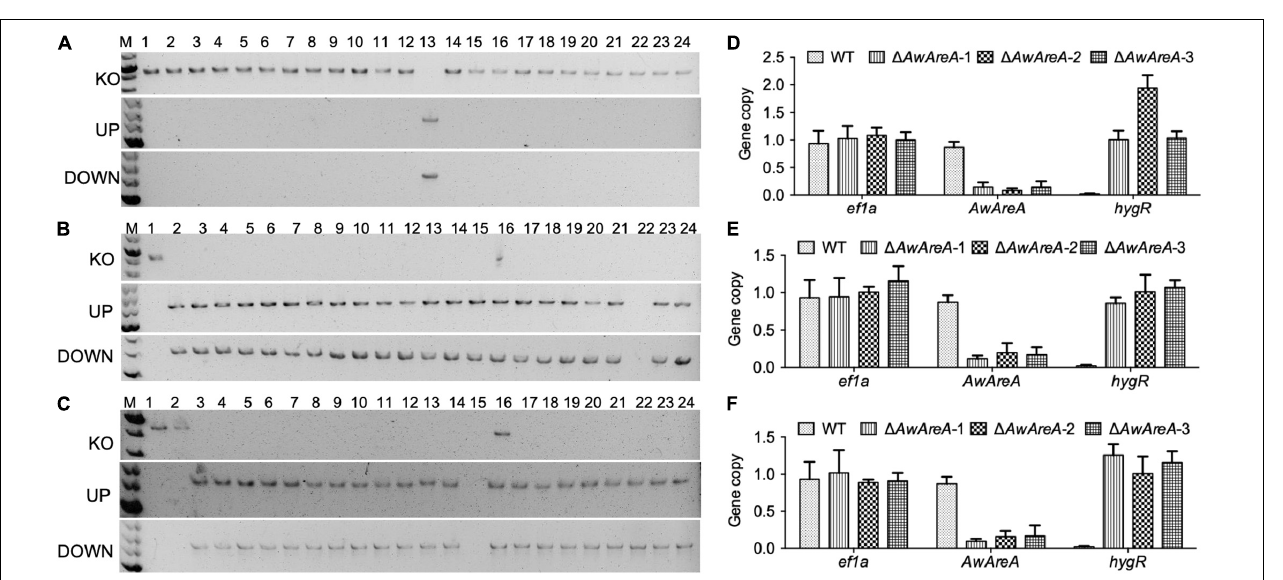
FIGURE 3 | Knockout of AwAreA in WT, (cid:49) Awku70 , and (cid:49) Awlig4 . PCR identification of (cid:49) AwAreA generated from WT (A) , (cid:49) Awku70 (B) , and (cid:49) Awlig4 (C) . For each parental strain, a total of 23 transformants (2–24) were randomly selected for PCR identification, with a parental strain (1) as control. The copy number hygR cassettes for WT (D) , (cid:49) Awku70 (E) , and (cid:49) Awlig4 (F) were determined by real-time genomic PCR